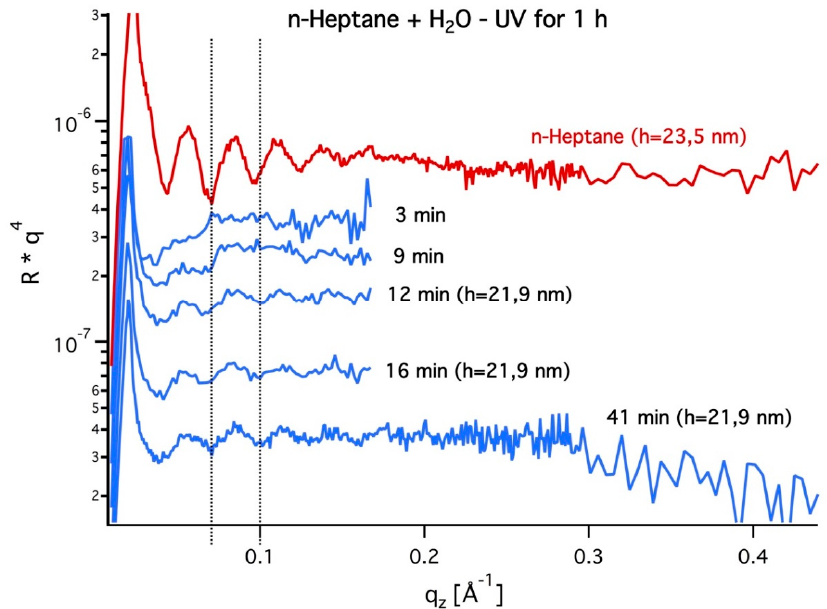
Figure 2. In-situ X-ray reflectivity curves of PS- h ν -PEO ultra-thin film UV-cleaved for 1 h during washing out the pore material. The red curve represents the sample in n-heptane for sample alignment. The blue reflectivity curves correspond to the measurements in ultra-pure water with the according washing time and film thickness h. The curves are plotted as R ∗ q 4 versus q z to eliminate the strong drop of the reflectivity and to enhance the visibility of the Kiessig fringes.